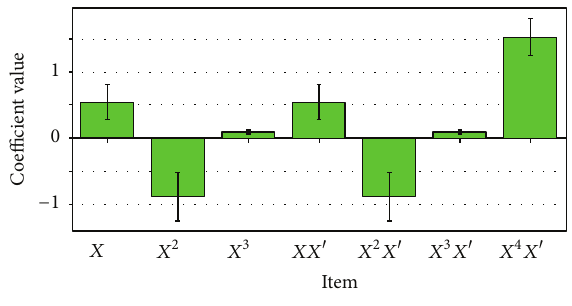
Figure 3: Coefficient values of each item.